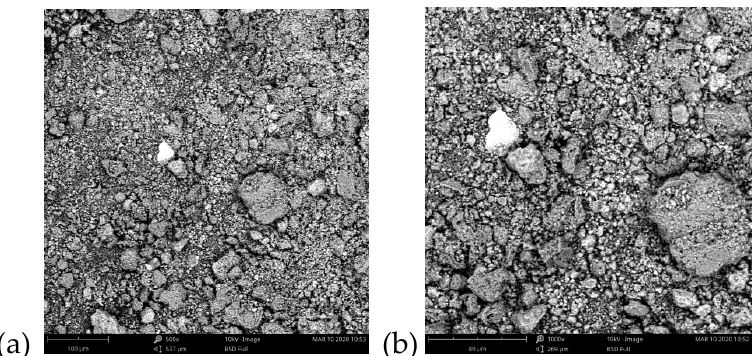
Figure 1. Scanning Electron Microscope (SEM) images of the C-SiO 2 composite of magnification 500 × ( a ) and 1000 × ( b ).